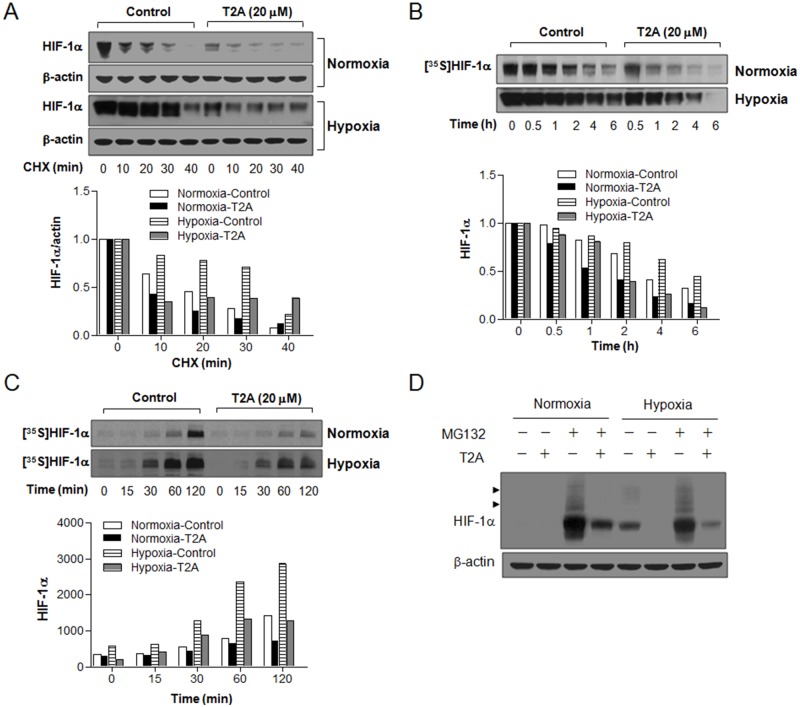
T2A inhibited HIF-1α expression through the inhibition of protein synthesis rather than the promotion of HIF-1α degradation.(A) The MDA-MB-231 cells were cultured under normoxic or hypoxic conditions for 8 hours, then pretreated without or with 20 μM T2A for 30 minutes, followed by treatment without or with 20 μM cycloheximide (CHX) for various intervals as indicated. Upper panel: after treatment, whole cell extracts were analyzed by Western blot using antibodies against HIF-1α and β-actin. Lower panel: quantification of the HIF-1α by densitometry following normalization to the β-actin level. The HIF-1α protein levels in untreated or T2A-treated cells were arbitrarily given the value of 100%. (B) Cells were labeled with [35S]methionine as described in the Methods section and chased for the indicated periods (h) in the presence or absence of T2A under normoxic or hypoxic conditions. Upper panel: equal amounts of proteins from each cell lysate were subjected to immunoprecipitation and then separated in SDS-PAGE and examined by autoradiography following normalization to the control. Lower panel: quantification of the autoradiographic HIF-1α signal by densitometry. (C) Cells were pretreated with either vehicle or 20 μM T2A for 16 hours and then subjected to hypoxia, or remained in normoxia for an additional 8 hours. Subsequently, cells were labeled with [35S]methionine in the presence or absence of 20 μM T2A for the indicated time. Upper panel: Equal amounts of proteins were subjected to immunoprecipitation and then separated in SDS-PAGE and examined by autoradiography. Lower panel: quantification of the autoradiographic HIF-1α signal by densitometry. (D) Cells were pretreated with the proteasome inhibitor MG132 (10 μM) for 2 hours, followed by T2A treatment (20 μM) under normoxic or hypoxic conditions as described above. Whole cell extracts were analyzed by Western blot using antibodies against HIF-1α and β-actin.